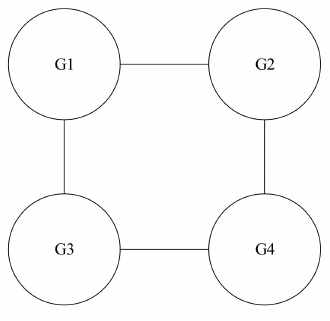
Figure 9. Power generation unit communication topology. The cost function parameters and output power constraints are shown in Table 3. Table 3. Parameters of power